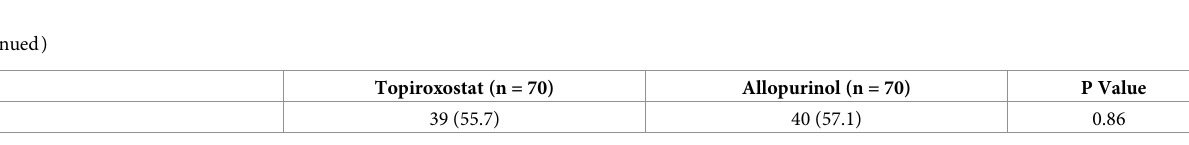
Table 2. Changes in study endpoints in FAS analysis.